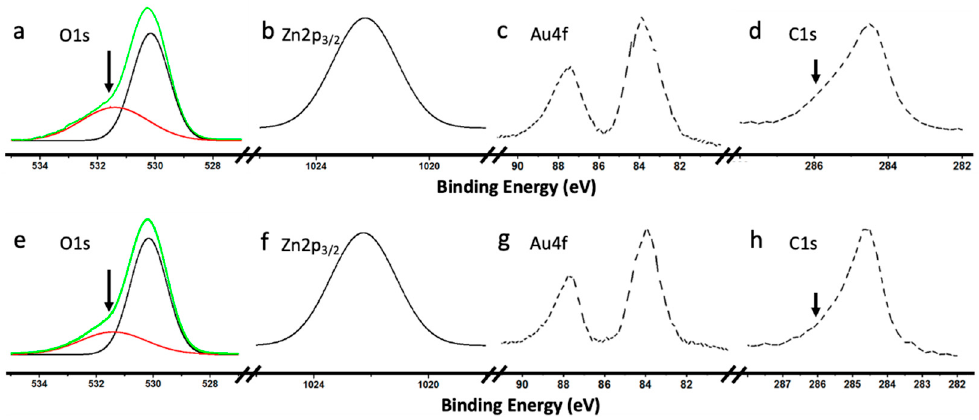
Figure 5. X-ray photoelectron spectroscopy (XPS) spectra of Zn 2p 3 / 2 , O 1s, Au 4f, and C1s taken from as-grown Au@ZnO NWs–graphene ( a – d ), and Au@ZnO NPs–graphene ( e – h ).